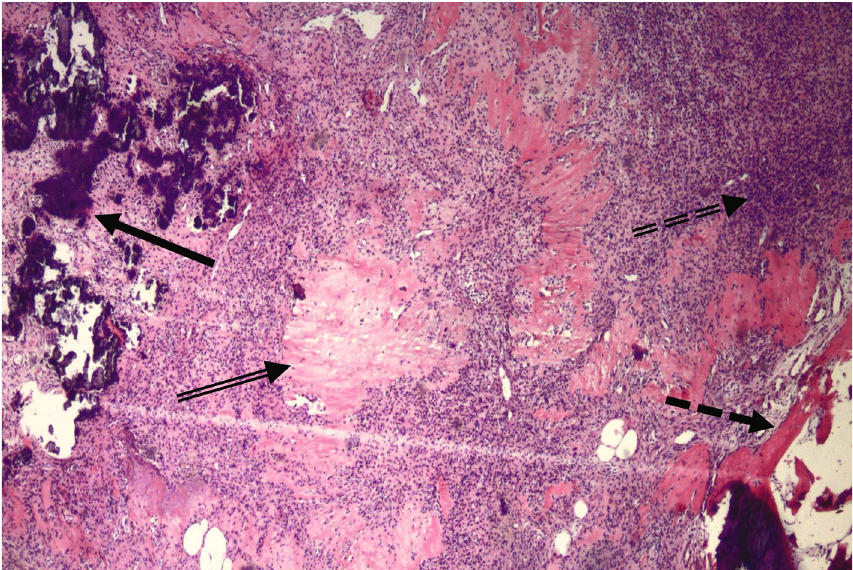
Figure 6: Photomicrograph of the specimen from Case 2. The tumor is composed of spindled to epithelioid cells admixed with few giant cells, with regions of grungy calci fi cation (solid arrow) and hyalinized matrix (double arrow), surrounded by a rim of bone (dashed arrow). The presence of regions with increased cellularity (double dashed arrow) and nuclear atypia are features that have been associated with a more aggressive tumor biology [4] (Hematoxylin and eosin, 4 ×